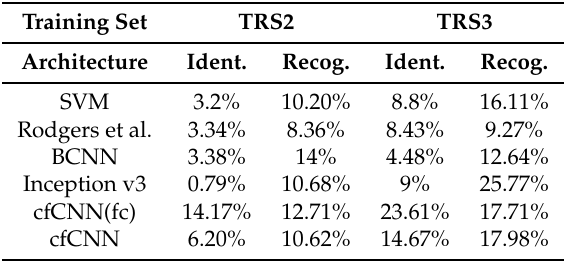
Table 2. The performance gains of different architectures on the real dataset (DR) relative to the same architecture trained on the TRS1 dataset. Each column indicates on which dataset the network was trained: TRS2 or TRS3. This include the results for the recognition and identification tasks. Training Set TRS2 TRS3 Architecture Ident. Recog. Ident.